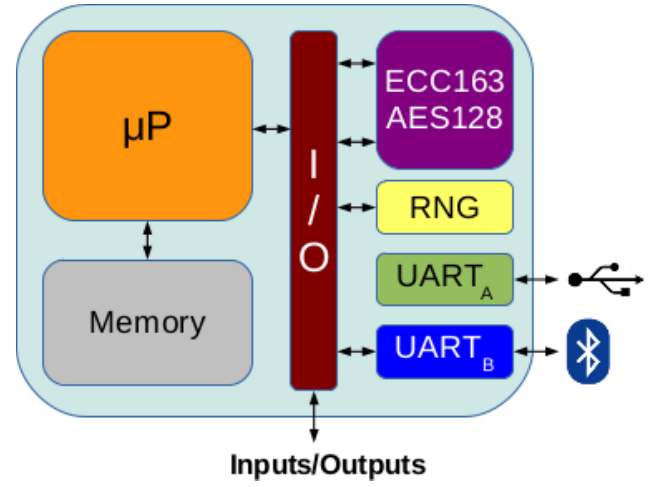
Figure 17. Block diagram of IoT monitoring system including